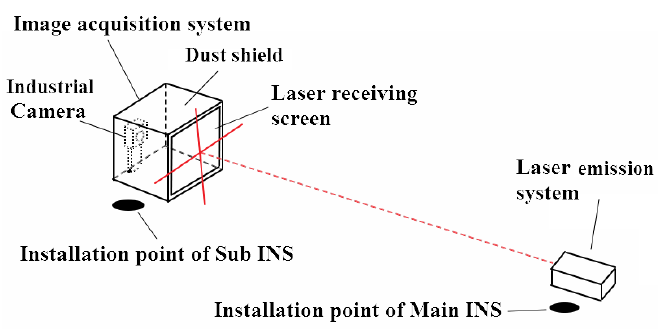
Figure 2. Schematic diagram of system composition.